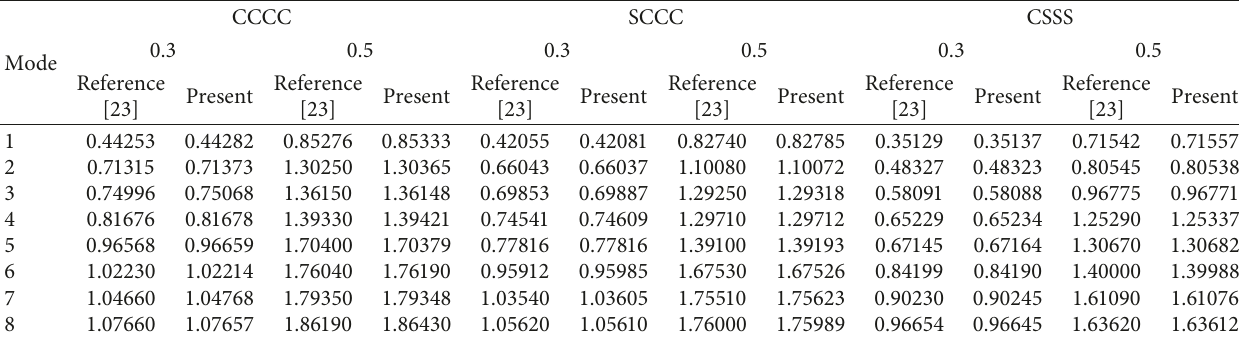
Table 6: Comparison of frequency parameters of a thick plate with different boundary conditions.